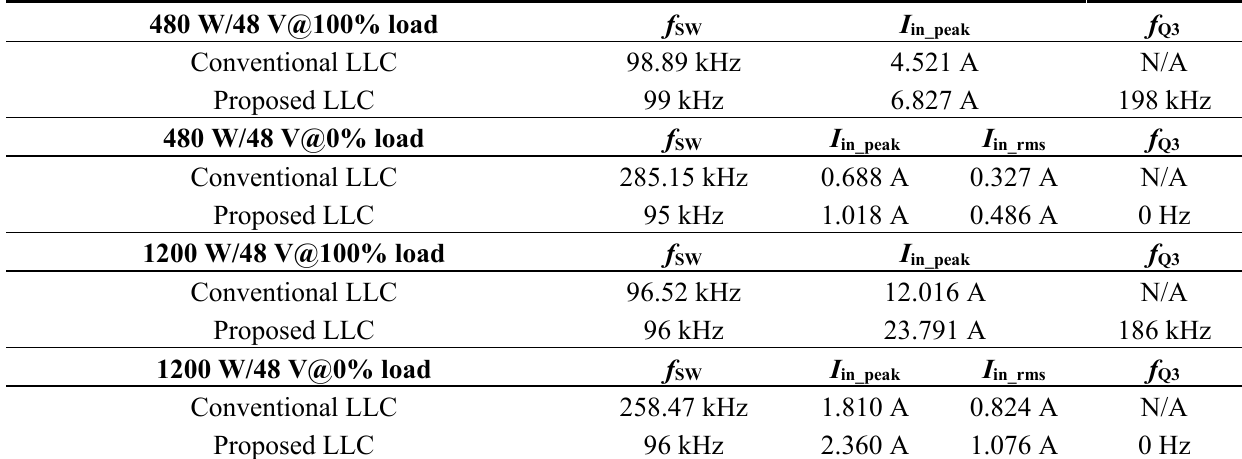
Table 1. Comparison between the simulation results for typical LLC circuit and new LLC